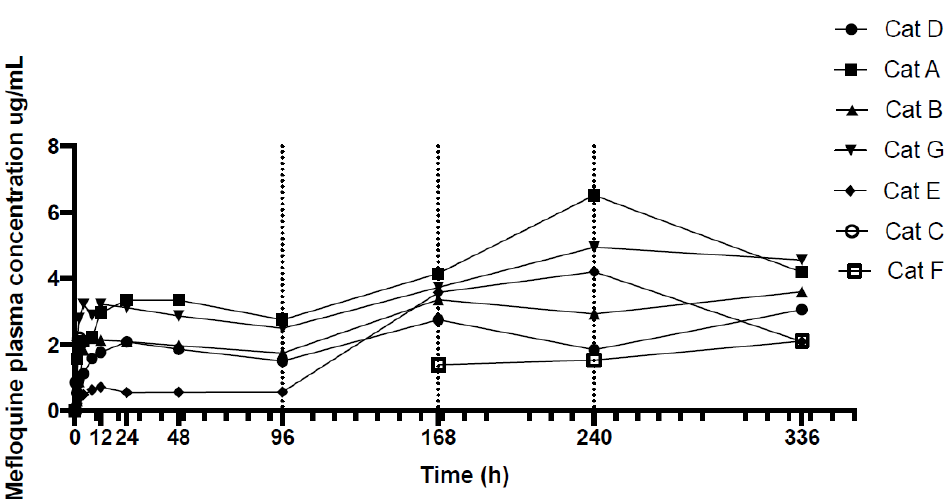
Figure 1. Mefloquine plasma concentrations (ug / mL) of seven cats over 336 h (14 days after initial dose). Cats were medicated with 62.5 mg per cat (10–12 mg / kg) after t = 0, 96, 168 and 240 h. Blood was taken just prior to treatment as denoted by vertical dotted lines. Table 1. Mefloquine plasma concentrations of individual cats. Cat C and F were excluded from pharmacokinetic (PK) analysis due to incomplete data. Cat C was removed from the study due to vomiting, while Cat F vomited after the first treatment but was successfully re-introduced into the study on treatment day 2. Cat E was excluded from PK analysis because this cat’s profile was an outlier and skewed the